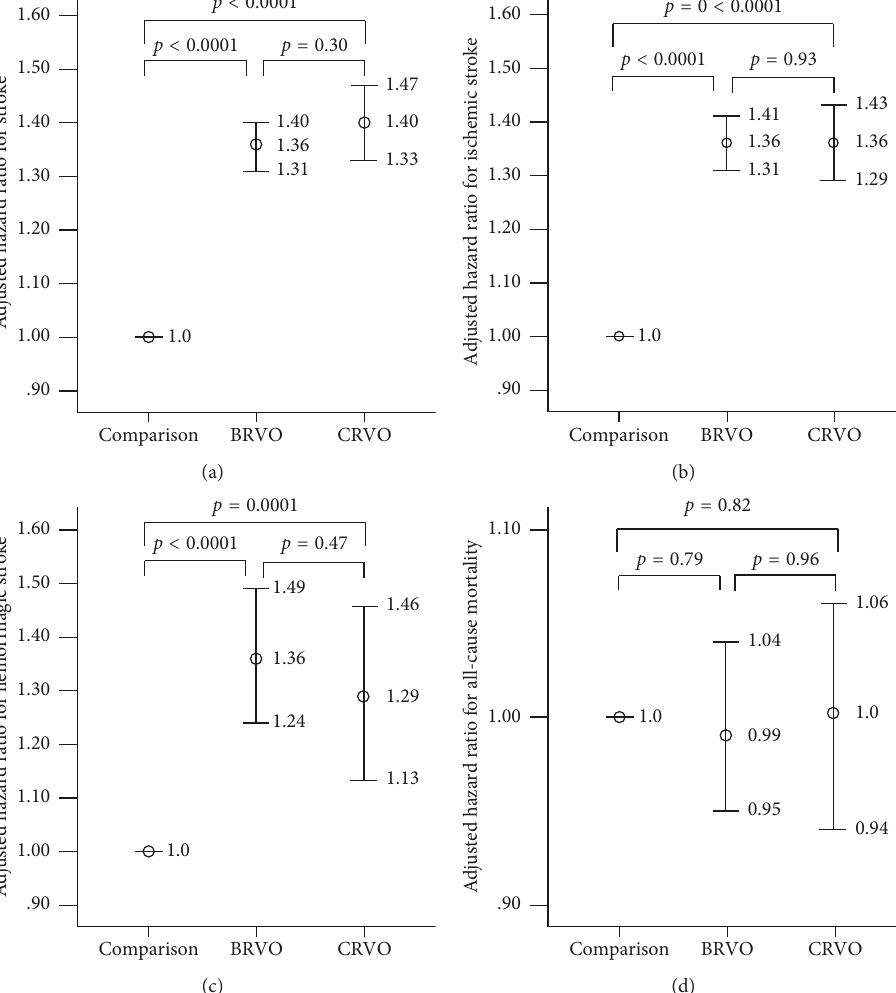
Figure 2: Adjusted hazard ratios for (a) stroke, (b) ischemic stroke, (c) hemorrhagic stroke, and (d) all-cause mortality in the BRVO and CRVO groups compared with the comparison group. BRVO: branch retinal vein occlusion; CRVO: central retinal vein